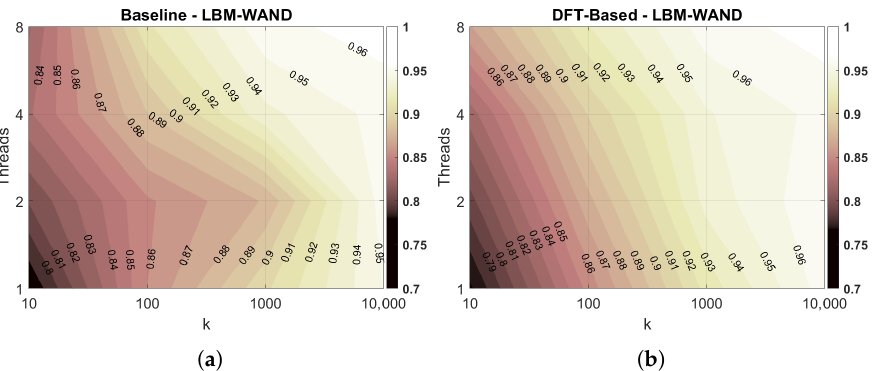
Figure 6. Pearson Correlation reported by the baseline and the DFT-based prediction algorithm with the LBM-WAND multi-thread strategy and ( a ) the Baseline prediction algorithm and ( b ) the DFT-Based prediction algorithm.